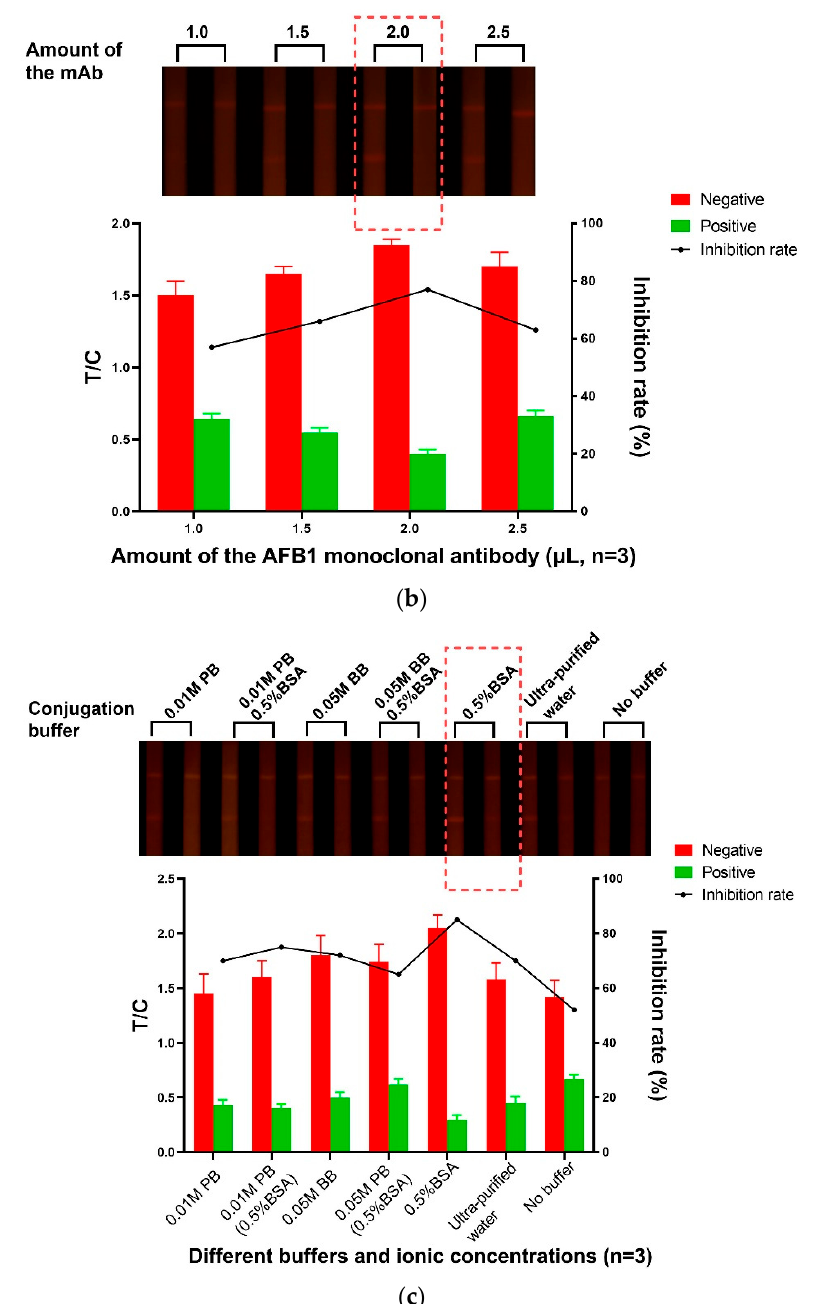
Figure 2. The fluorescence intensity, inhibition effect, and inhibition rate of the FM immunoprobe: ( a ) Activation pH value; ( b ) Amount of the AFB1 monoclonal antibody; ( c ) the conjugation buffer.